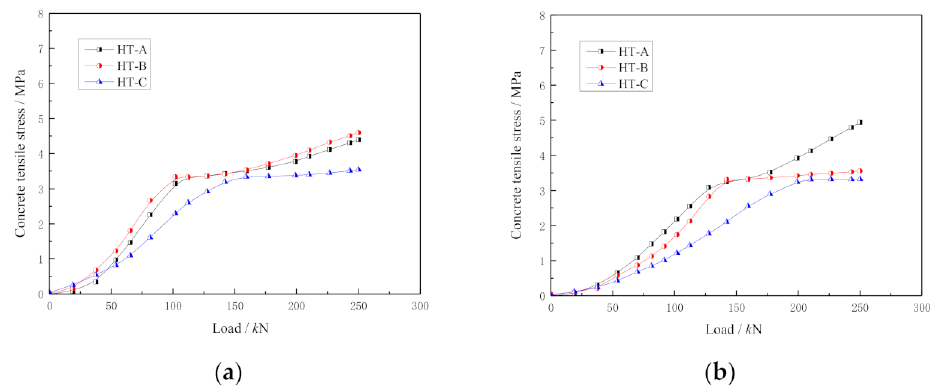
Figure 19. Concrete stress curve of GD-2 specimen: ( a ) No. 1 measuring point and ( b ) No. 2 measuring